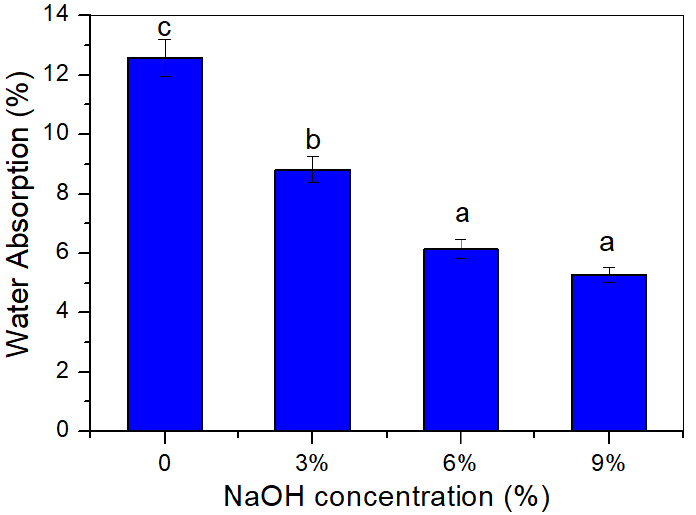
Figure 10. Water absorption of untreated and treated TPCS/PW/CCF composites. Letters a, b, and c is indicates the group of data for statistical analysis.